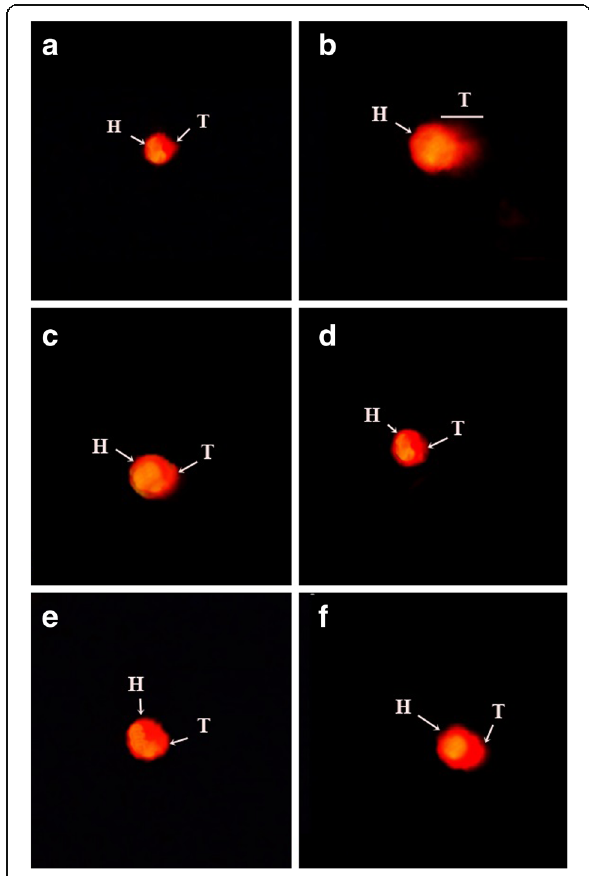
Fig. 3 Genotoxicity evaluation of I. batatas on blood lymphocytes. a Vehicle control (1% DMSO) ( b ) Ethyl methane sulfonate (20 μ g/ml) ( c ) IPT-EA (100 μ g/ml) ( d ) IPR-EA (100 μ g/ml) ( e ) IPR-M (100 μ g/ml) and ( f ) IPT-M (100 μ g/ml). “ H ” shows head of comet and “ T ” is the tail